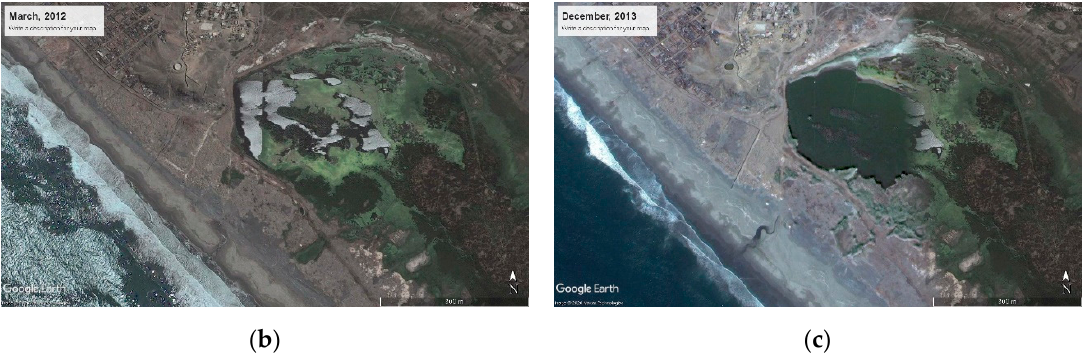
Figure 1. ( a ) Picture of the Cascajo Wetlands covered by invasive plant, Pistia stratiotes, taken in January 2011; ( b ) Aerial picture in March 2012, presented by Google Earth; ( c ) Aerial photograph in December 2013, presented by Google Earth.